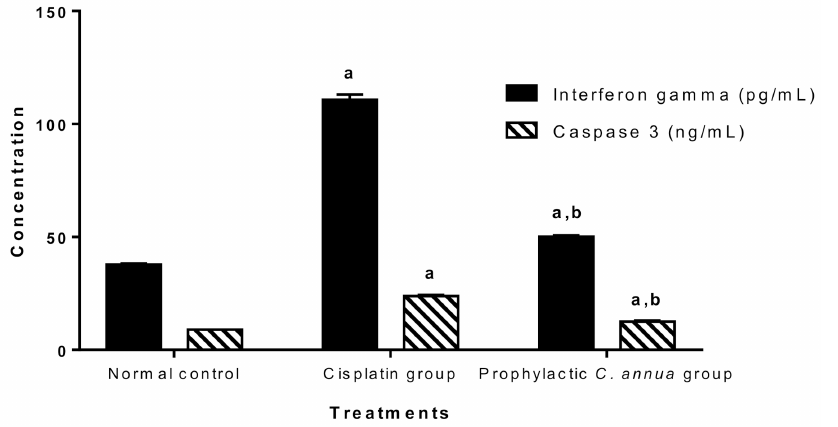
Figure 2. Inflammatory marker (interferon gamma) and apoptotic marker (caspase 3) in the studied groups. Data are represented as mean ± SE and analyzed using ANOVA followed by Bonferroni’s post hoc test at p value < 0.05, n = 10 for each group. a indicates the presence of significant difference from normal control group, b indicates the presence of significant difference from cisplatin